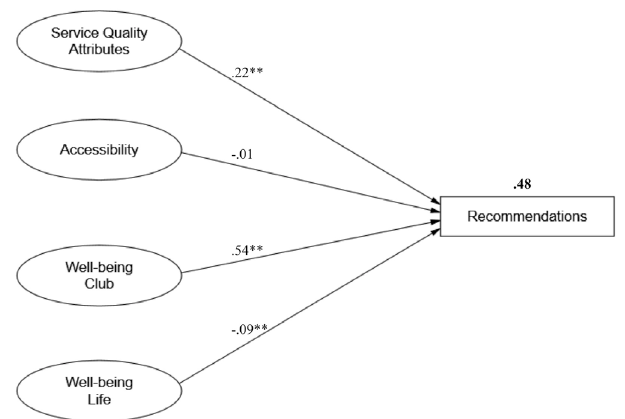
Figure 1. Estimated standardized effects for the structural